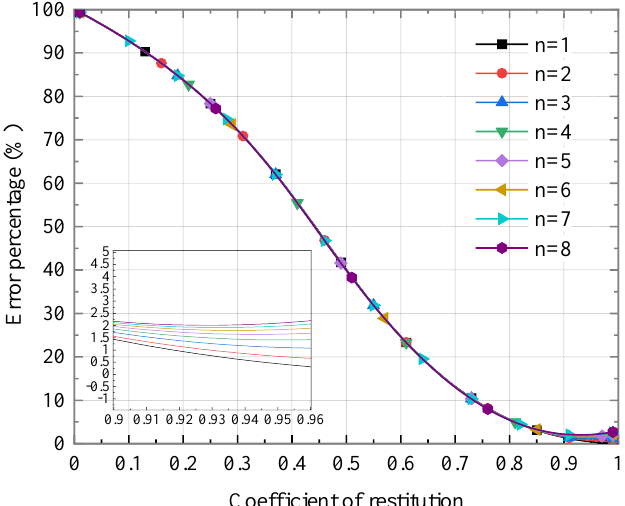
Figure 7. Evaluation of the coefficient of restitution.